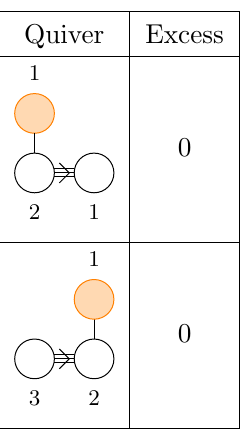
Table 11 . Classi(cid:12)cation of minimally unbalanced quivers with G = G 2